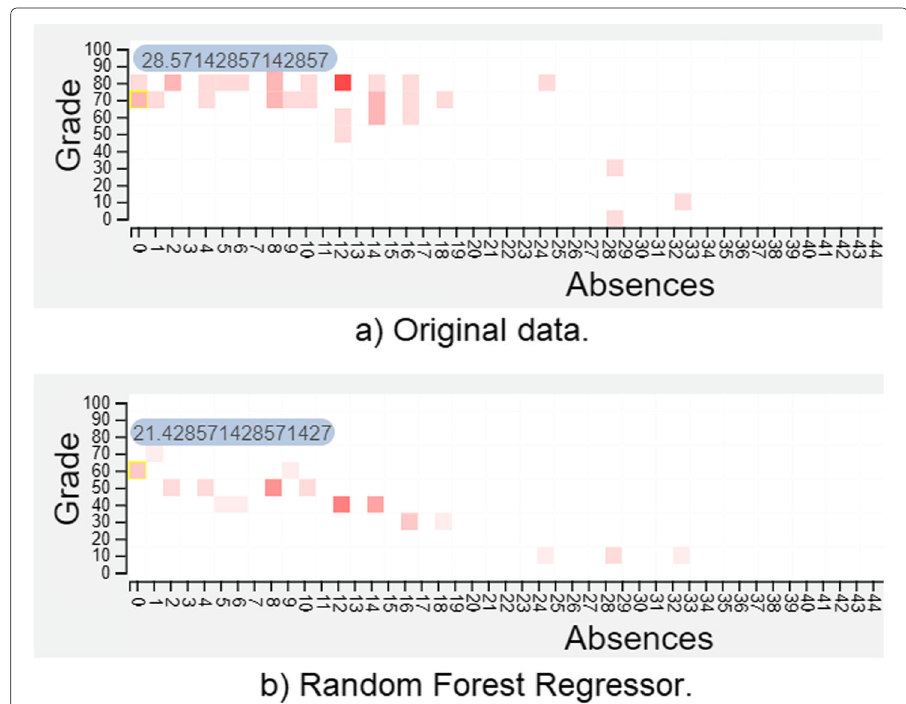
Fig. 2 Heatmap Matrix visualization of Attendance vs. Grade for HCI subject